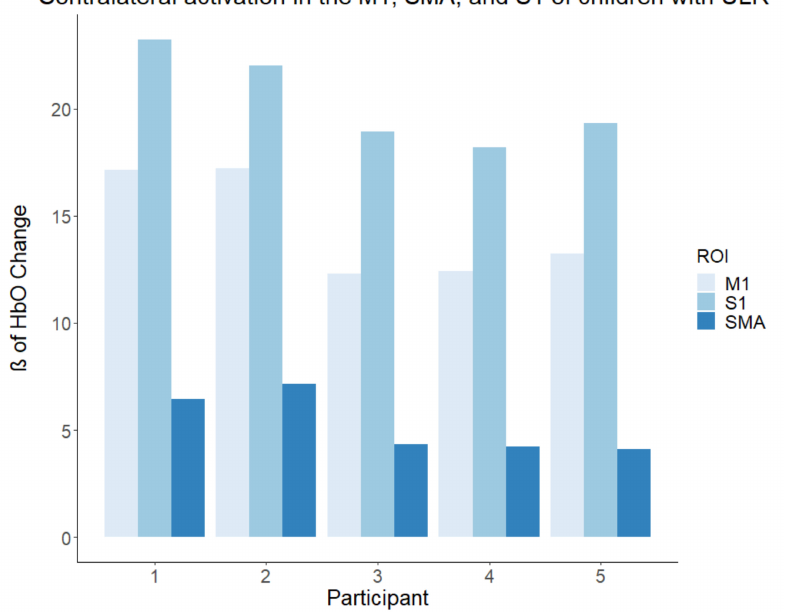
Figure 3. Activation in the ULR group during prosthetic usage. Beta (ß) values produced by the GLM are used as markers of activation with the brain, indicating that the activation matched the expected canonical hemodynamic response. The ULR group displayed lower activation in the M1 and SMA, and comparable S1 activation compared to TD children using the